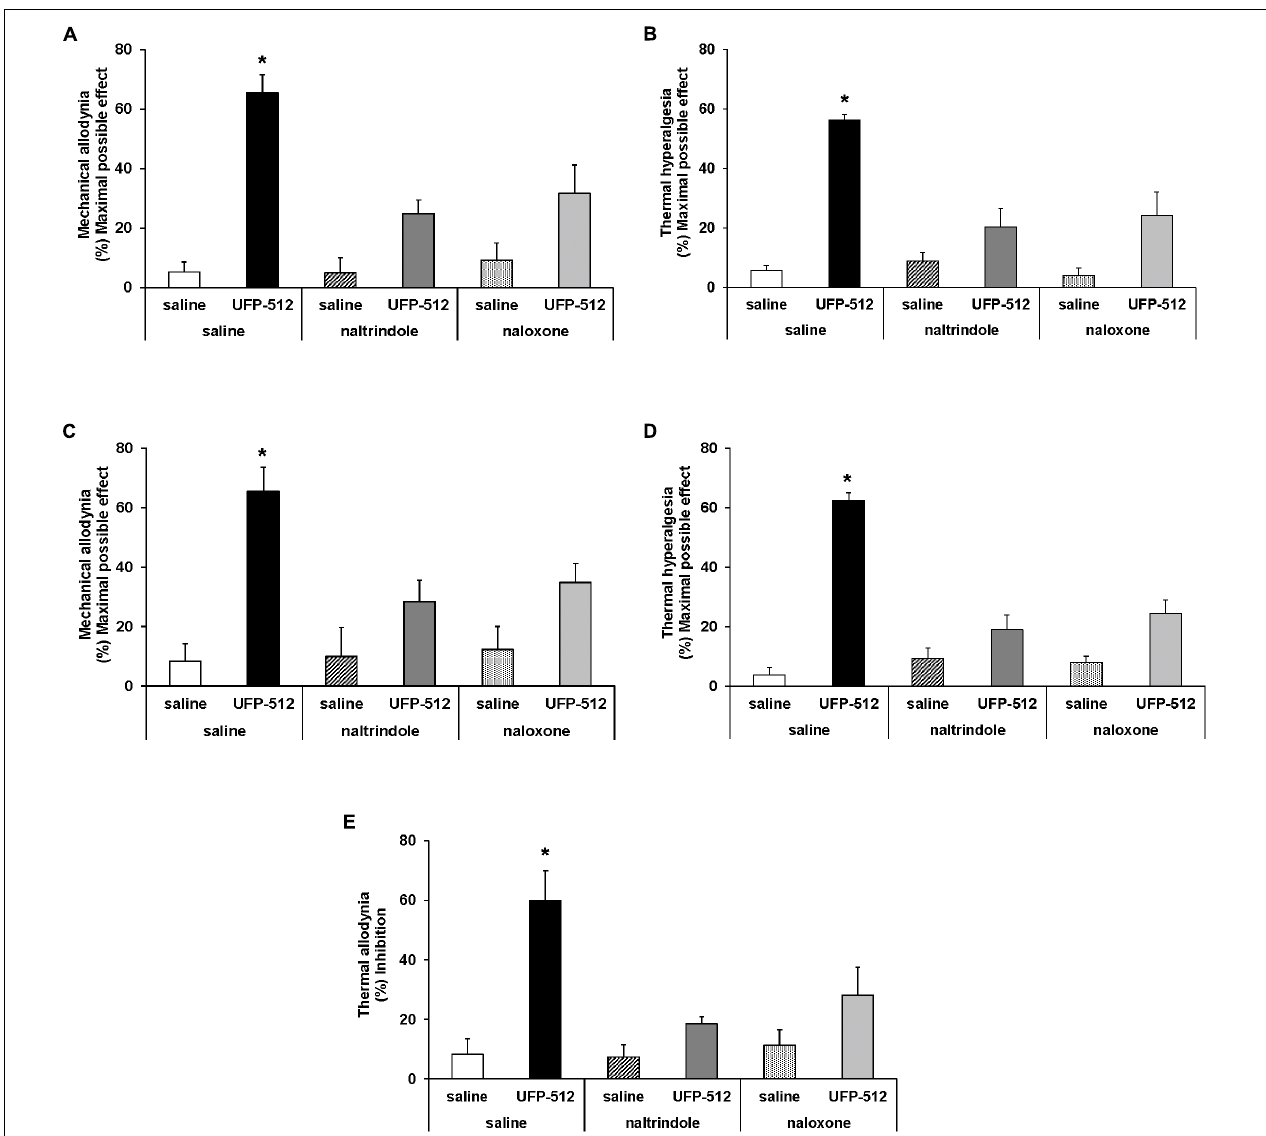
FIGURE 3 | Reversion of the antiallodynic and antihyperalgesic effects of UFP-512. Reversal of the effects induced by 30 mg/kg UFP-512 on the mechanical allodynia (A) and thermal hyperalgesia (B) induced by CFA, and on the mechanical allodynia (C) , thermal hyperalgesia (D) , and thermal allodynia (E) caused by CCI, in ipsilateral paws, with the administration of the specific DOR antagonist, naltrindole (4 mg/kg), and the unspecific opioid antagonist, naloxone (1 mg/kg) are shown. The effects of vehicle, naltrindole (4 mg/kg), or naloxone (1 mg/kg) administered alone are also represented. UFP-512 was intraperitoneally injected 1 h before testing while both naltrindole and naloxone were subcutaneously injected 30 min before testing. For each test, ∗ represents significant differences compared to the other groups ( P < 0.05; one-way ANOVA, followed by the Student–Newman–Keuls test). Data are expressed as mean values of maximal possible effect (%) for mechanical allodynia and thermal hyperalgesia, and inhibition (%) for thermal allodynia ± SEM (six animals for each group).